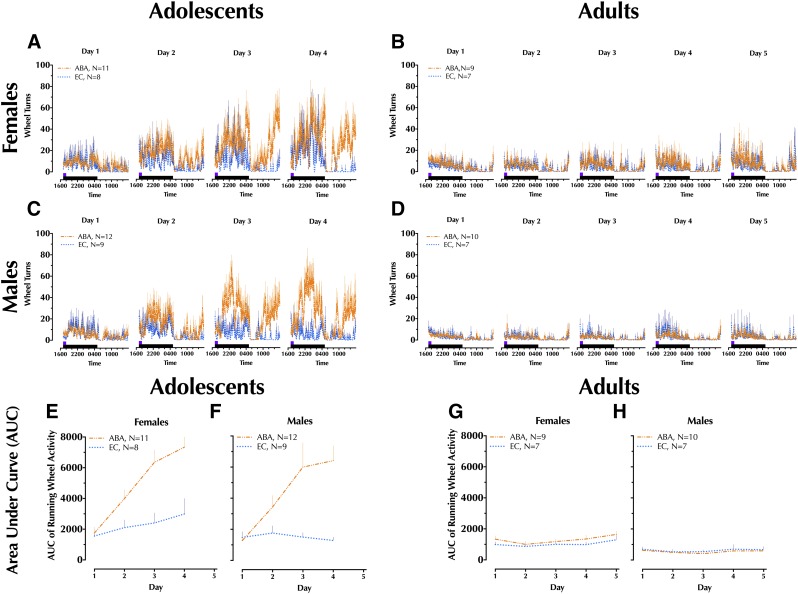
Daily running wheel measures in drug-naive rats. Adolescents were run in the experimental paradigm for 4 days, whereas adults were run for 5 days. Because animals used for chronoamperometry and cocaine-induced locomotion were removed prior to completion of their full fourth (adolescents) or fifth (adults) day, only data from drug-naive rats are shown here. Collected in 5 minute bins, 23 hours of running wheel activity were recorded each day for (A) adolescent female and (B) male running wheel activity over four paradigm days; (C) adult female and (D) male running wheel activity over five paradigm days. Area under the curve (AUC) was calculated for each day from the graphs in (A–D), and are shown for (E) adolescent female and (F) male animals; (G) adult female and (H) male animals. No running wheel activity is shown for CC and FC animals, because their wheels were locked and therefore they could not run in the wheel. Only the final day of wheel running activity was analyzed (refer to Fig. 2, E and F). Data are graphed as mean + S.E.M. Number of animals is indicated in line legend: exercise control (EC), activity-based anorexia (ABA).